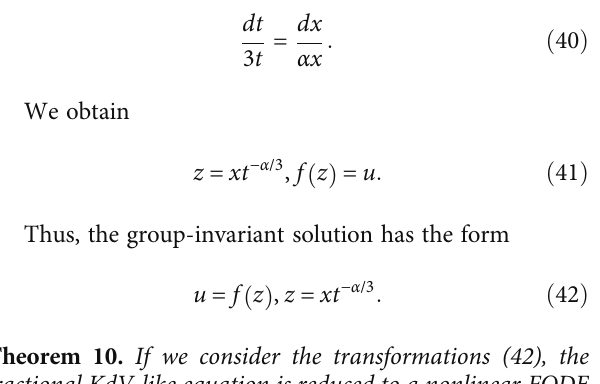
Figure 1: The solution u